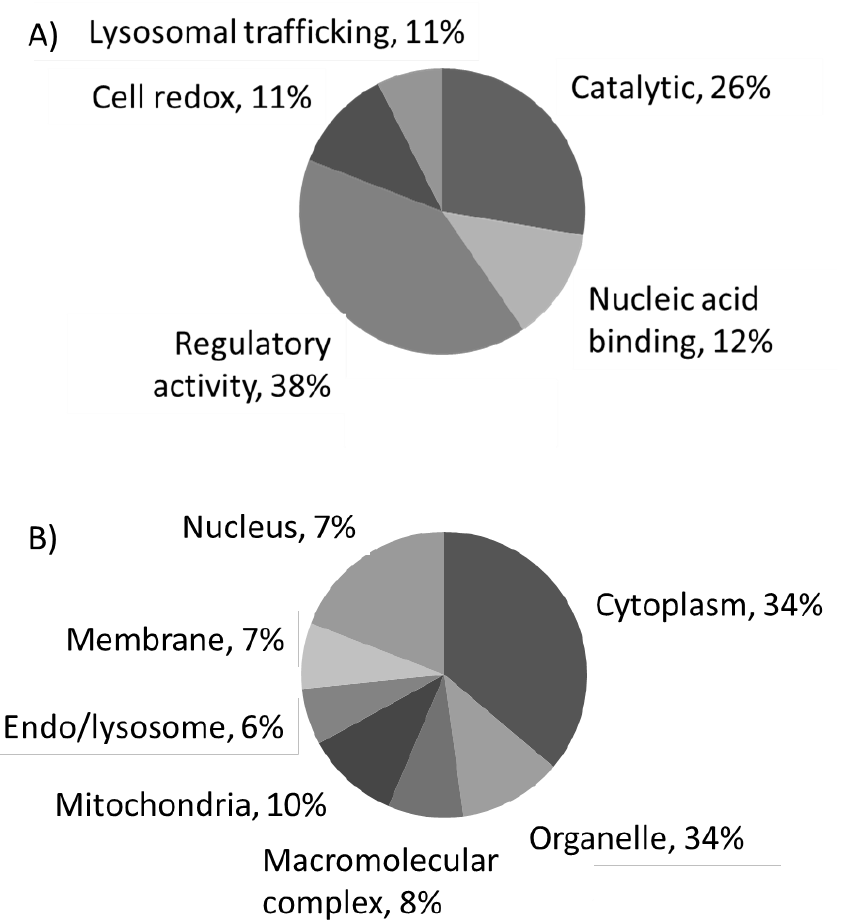
Figure 5. Summarized functional categorization of the positively identified human-like macrophage cell proteins, according to their molecular function ( A ) and their cellular localization ( B ). Table 1. Proteins identified by RP-LC-MS/MS in human-like macrophage cells incubated with extracts from Chenopodium quinoa and Salvia hispanica L compared to untreated controls.